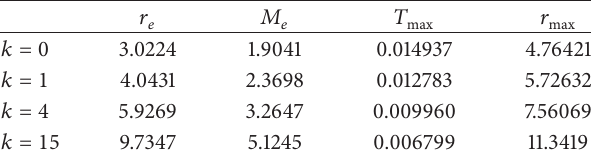
Table 1: Some values of parameters of the matter